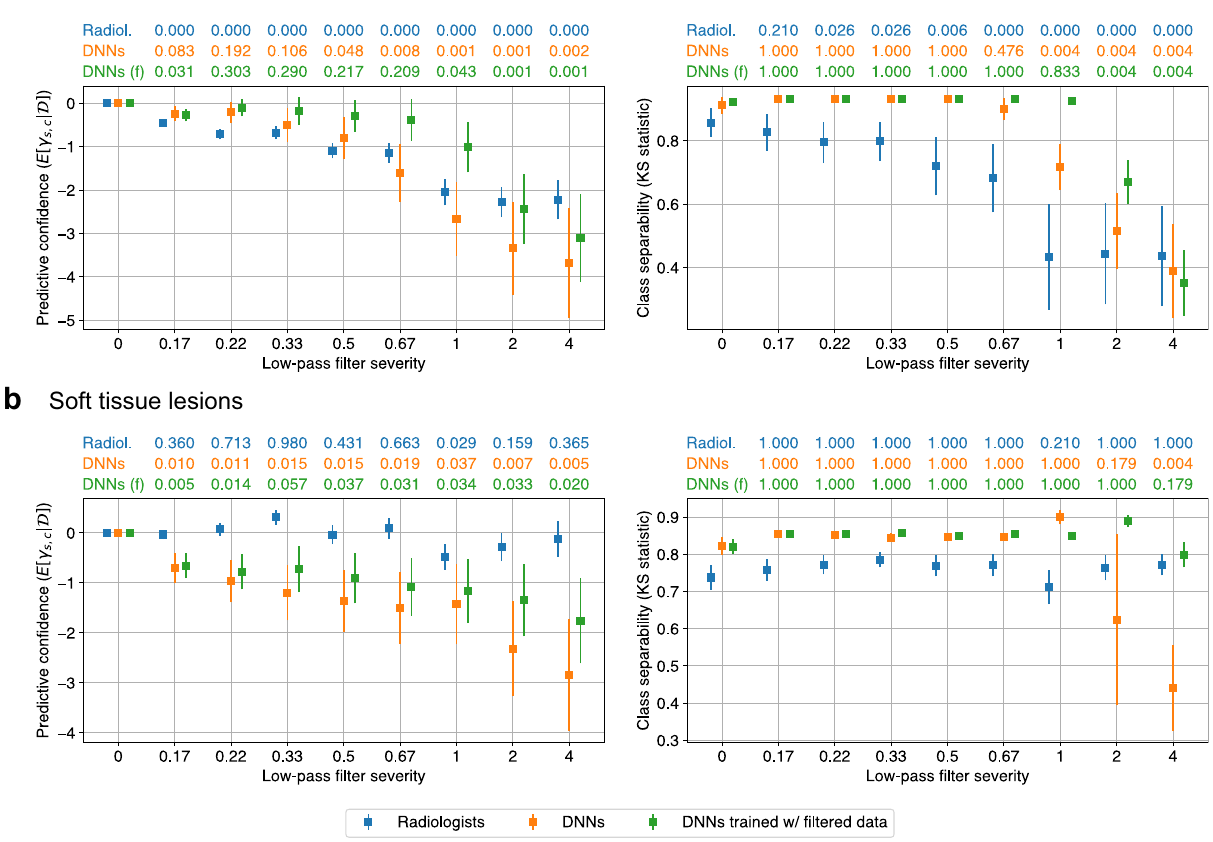
Figure 4. Comparing human and machines with respect to their perturbation robustness. The left subfigures represent the effect on predictive confidence, measured as the posterior expectation of γ s , g for severity s and subgroup g . The values at the top of each subfigure represent the probability that the predictive confidence for each severity is greater than zero. Smaller values for a given severity indicate a more significant downward effect on predictive confidence. The right subfigures correspond to the effect on class separability, quantified by the two-sample Kolmogorov–Smirnov (KS) statistic between the predictions for the positive and negative classes. The values at the top of each subfigure are the p -values of a one-tailed KS test between the KS statistics for a given severity and severity zero. Smaller values indicate a more significant downward effect on class separability for that severity. (a) For microcalcifications, low-pass filtering degrades predictive confidence and class separability for both radiologists and DNNs. When DNNs are trained with filtered data, the effects on predictive confidence and class separability are reduced, but not significantly. (b) For soft tissue lesions, filtering degrades predictive confidence and class separability for DNNs, but has no effect on radiologists. When DNNs are trained with filtered data, the effect on predictive confidence is reduced, and DNN-derived class separability becomes invariant to filtering. Figure created with drawio v13.9.0 https:// github. com/ jgraph/